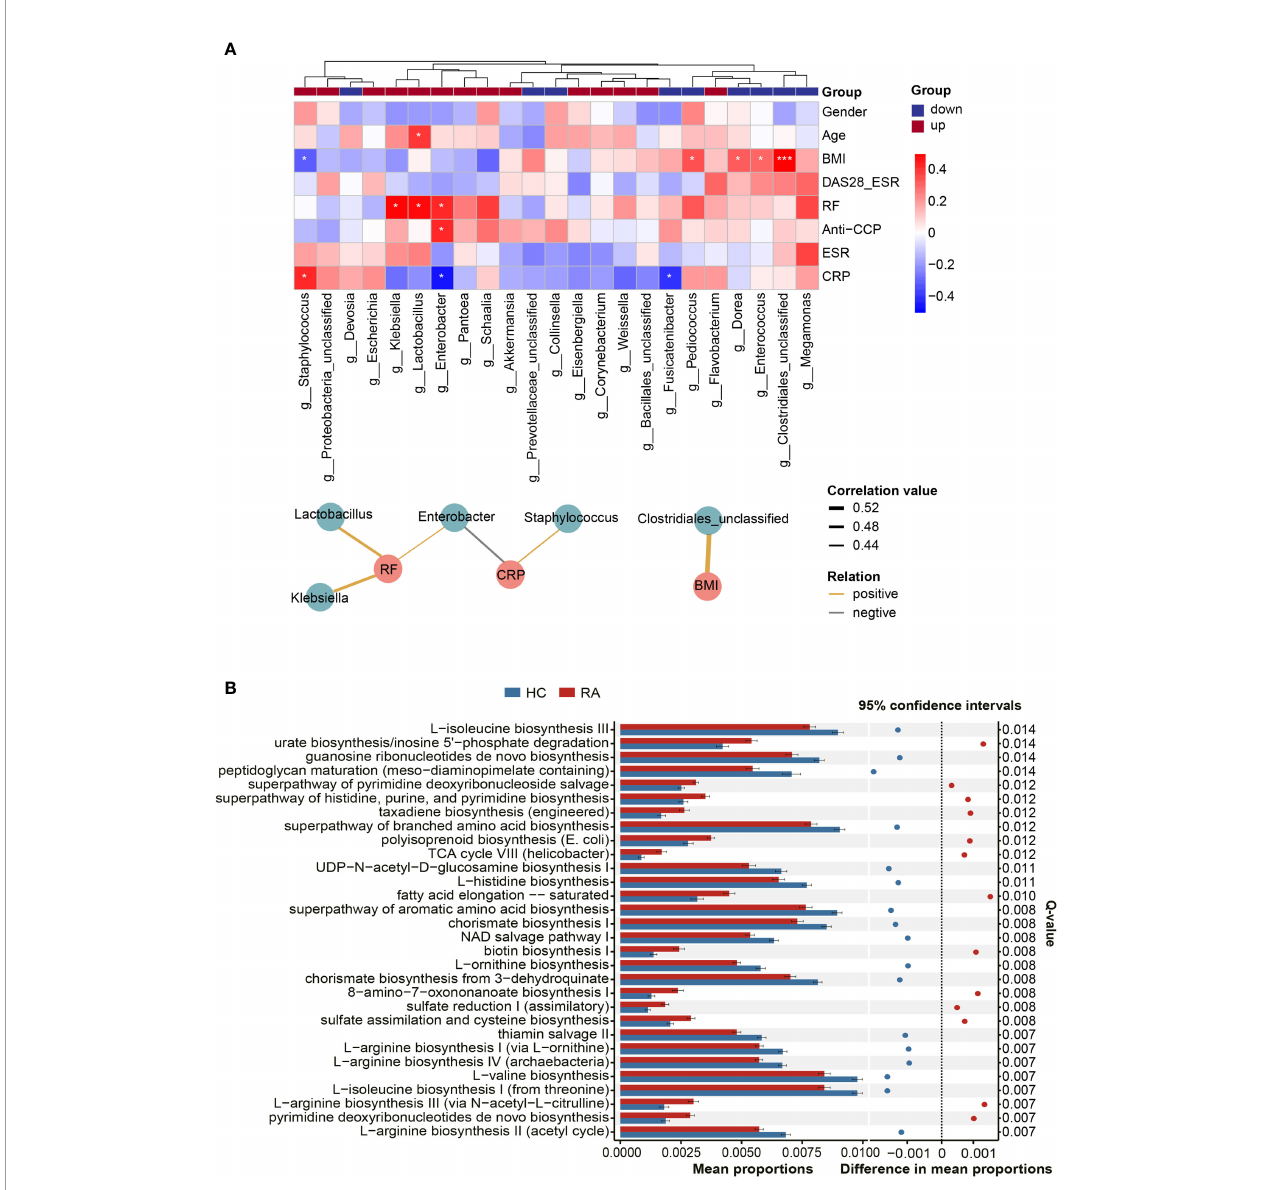
FIGURE 3 | Correlations between microbes and clinical indicators and function prediction analysis. (A) The heatmap revealed correlations between differentially abundant genera and clinical indicators, and partial correlations (Spearman ’ s correlation analysis, r > 0.4, p < 0.05) were shown in co- occurrence networks. Asaccharobacter , Aeromonas and Gelria were excluded because they were only identi fi ed in the healthy controls. Genera were divided into two groups based on their alterations in the RA group. P-value, *p < 0.05; ***p < 0.001. (B) The top 30 KEGG pathways with the most signi fi cant difference in function